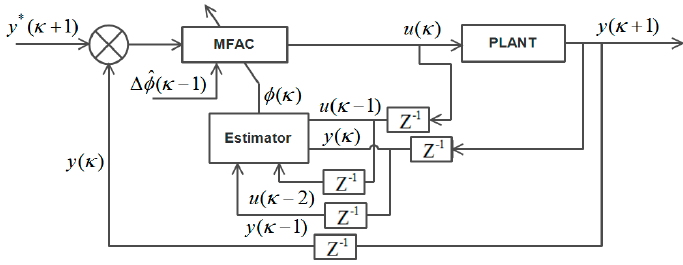
Figure 13. General Block diagram of Model Free Adaptive Control.